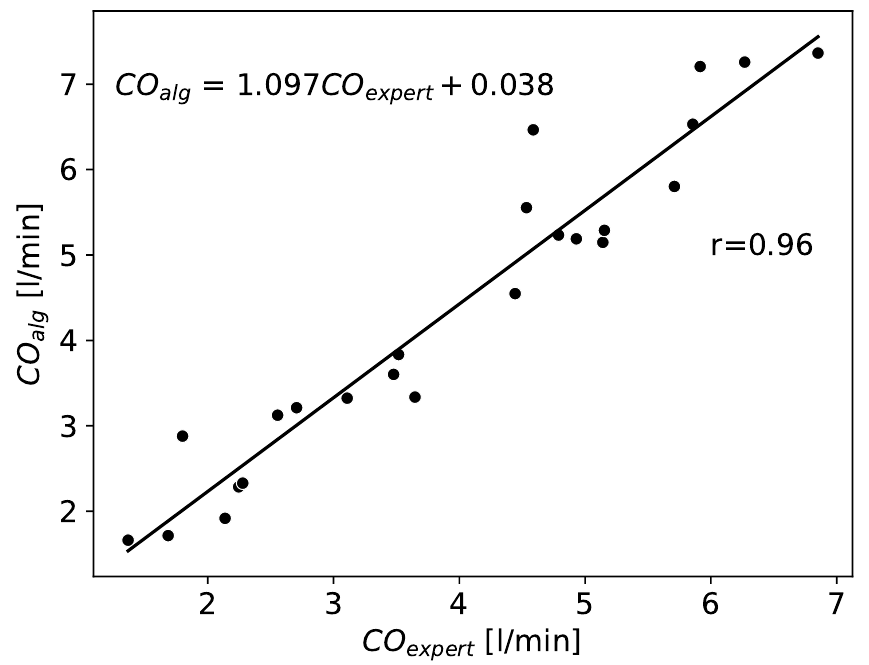
Figure 8. The plot illustrating the fit of the cardiac output (CO) as predicted by the algorithm ( CO alg ) and resulting from the estimations made by an expert ( CO exp ). The presented equation illustrates the relationship between these two approaches obtained by the method of linear regression. The number r stands for the Pearson correlation